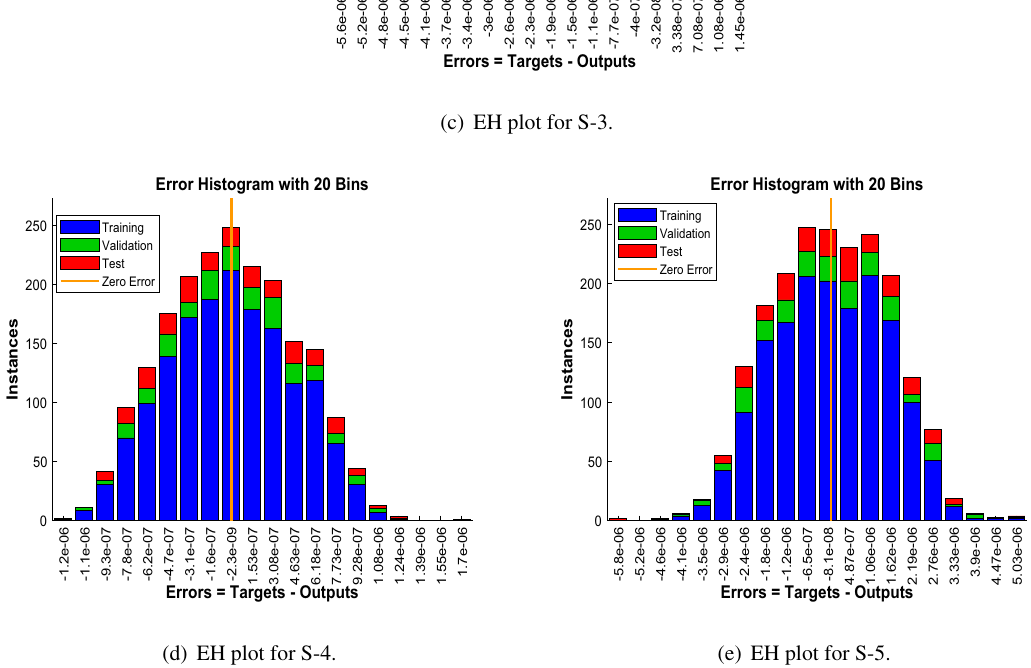
(c) EH plot for S-3.